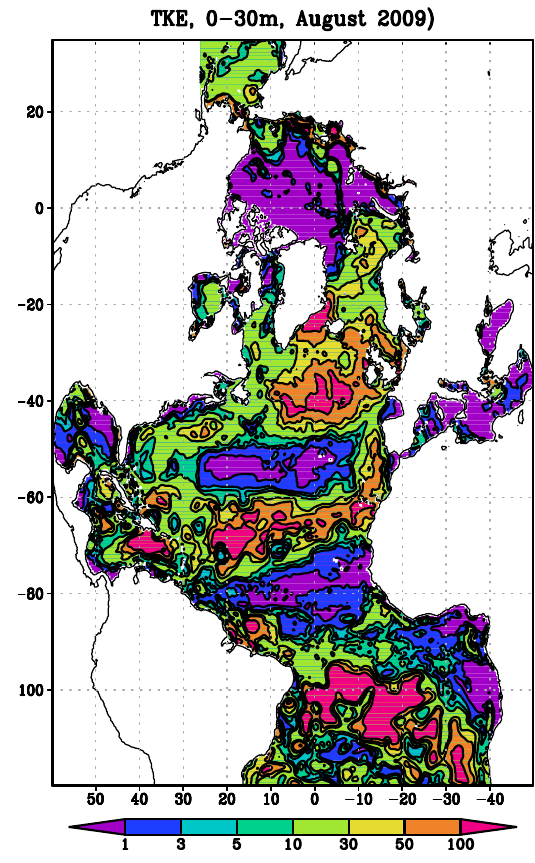
Figure 10. Turbulent kinetic energy (cm 2 /s 2 ) in the 0–30 m layer in August 2009 (the 62nd year of integration). The model coordinates are used (see the caption under Figure